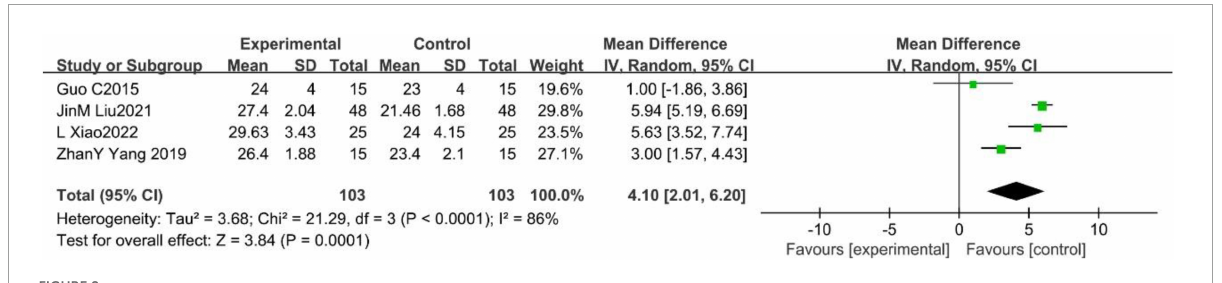
FIGURE8 Forest plot of the effects of WBV training on